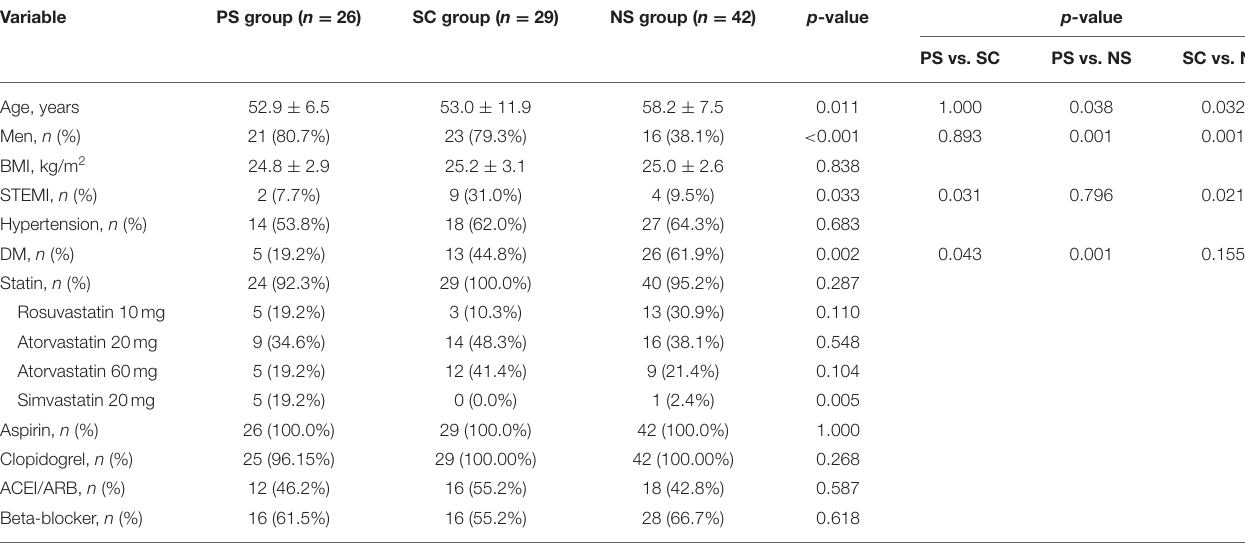
TABLE 1 | Baseline characteristics.